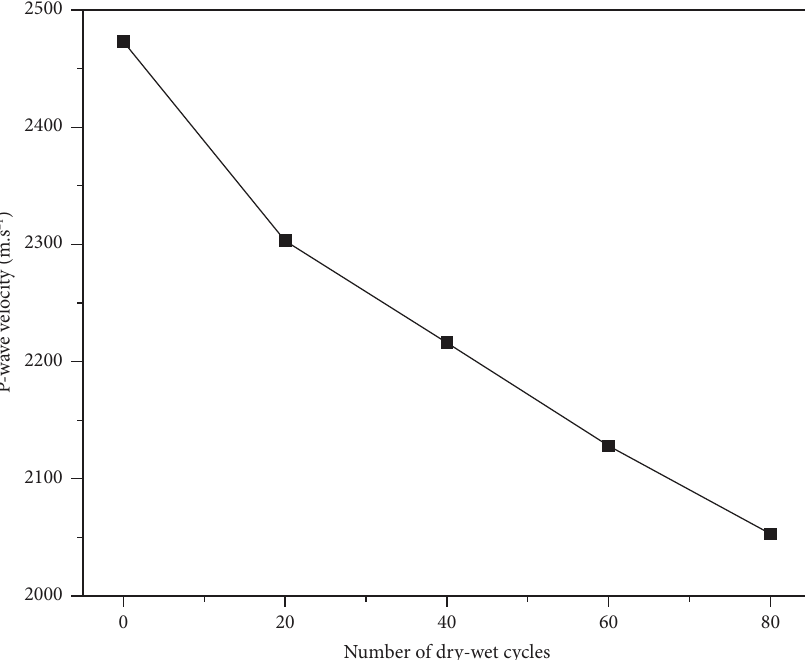
Figure 4: Change law of longitudinal wave velocity of the red-sandstone versus n